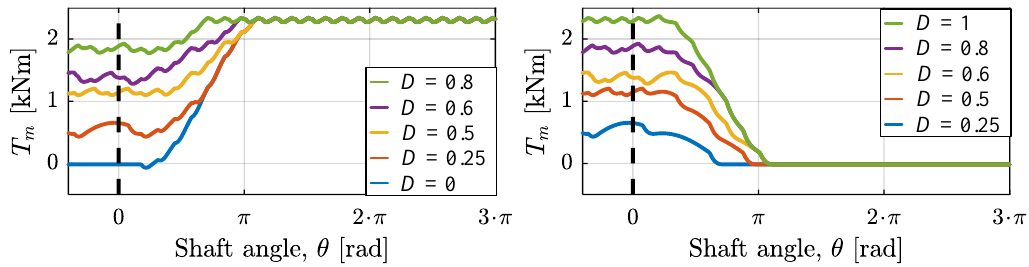
Figure 17. Step-up response ( left plot ) and step-down response ( right plot ) using FSDS with variable response angles.